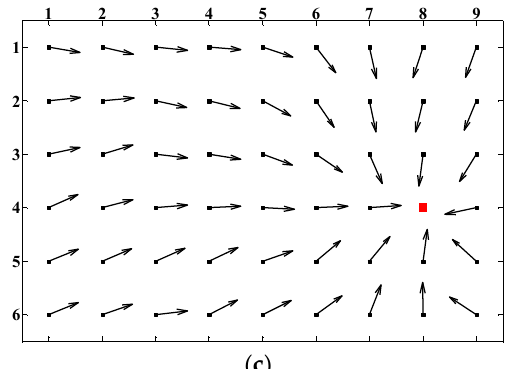
Figure 10. Homing vector fields (50 cm spacing): ( a ) homing vector field of ALV; ( b ) homing vector field of SL-ALV; and ( c ) homing vector field of the proposed strategies. Red squares denote the pre-set target location. Black arrows represent the calculated homing vectors pointing from the possible current location to the target location.